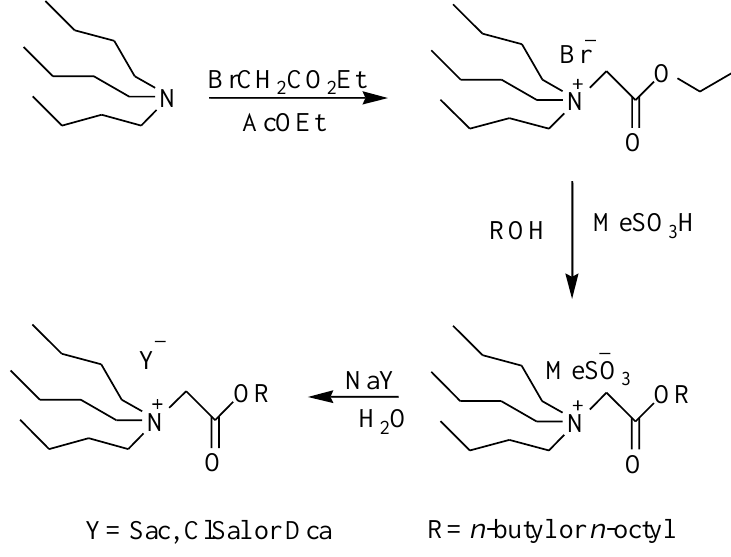
Figure 2. Synthetic route of hydrophobic ionic liquids.